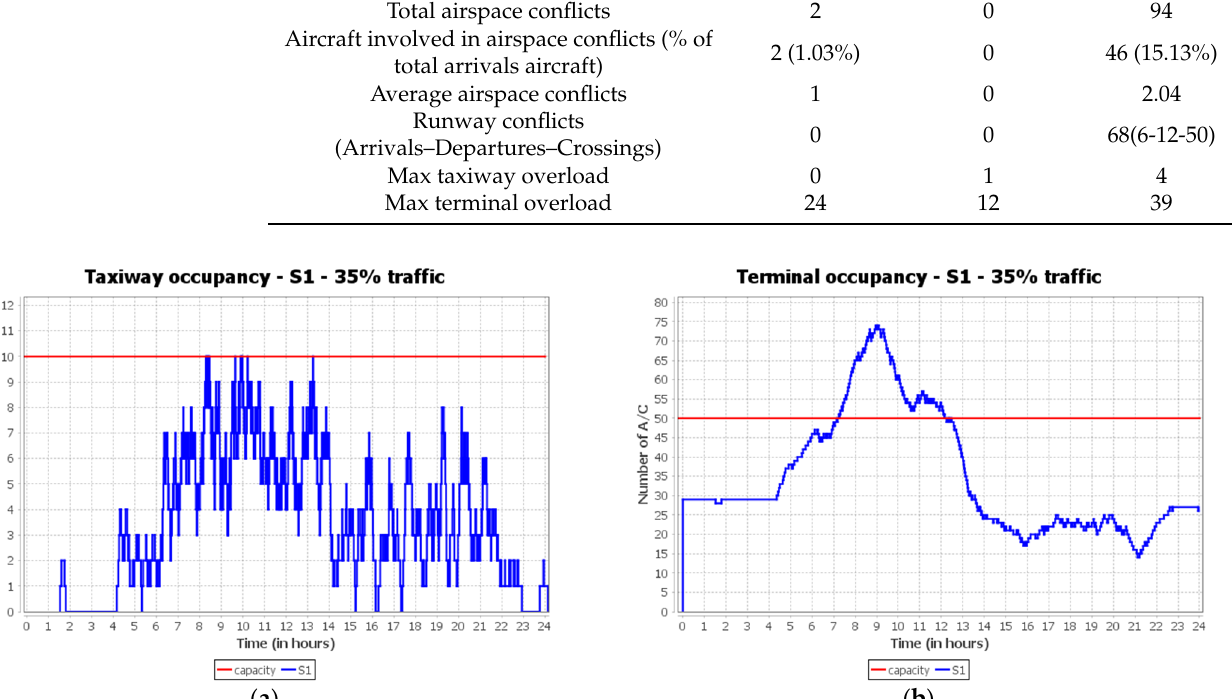
Figure 7. Taxiway ( a ) and terminal ( b ) occupancy scenario S1.